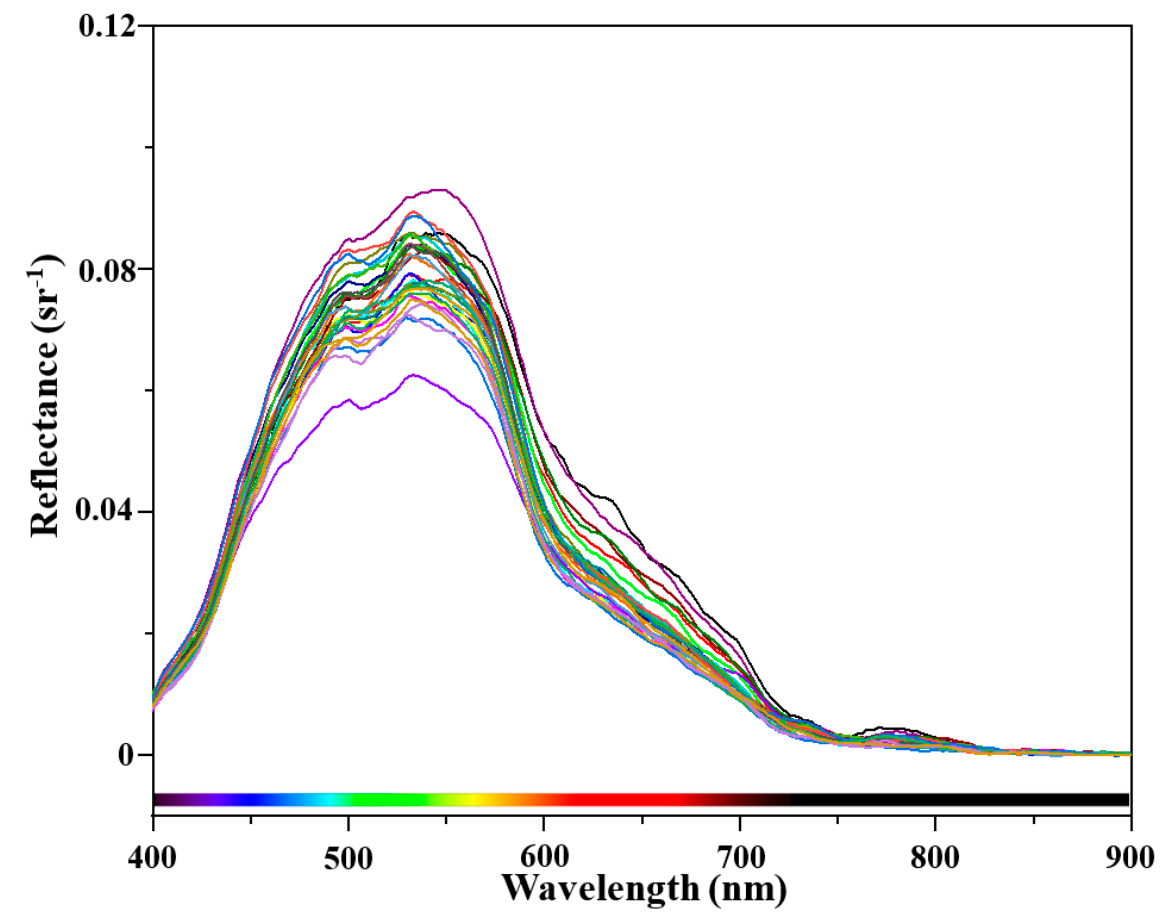
Figure 3. Water spectral curves of the seawater sampling sites.